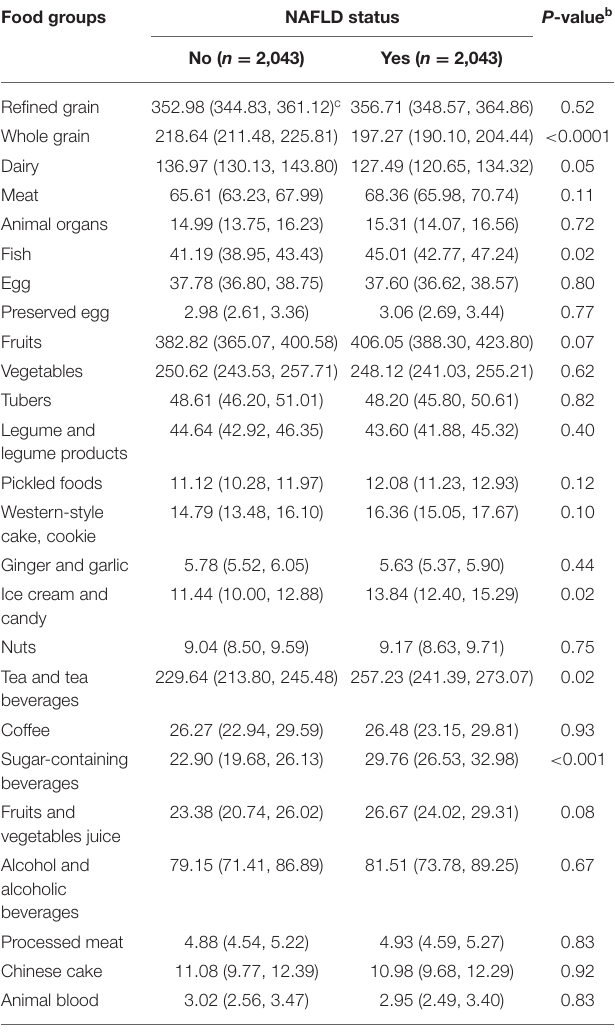
TABLE 2 | Average intake of food groups according to NAFLD status a